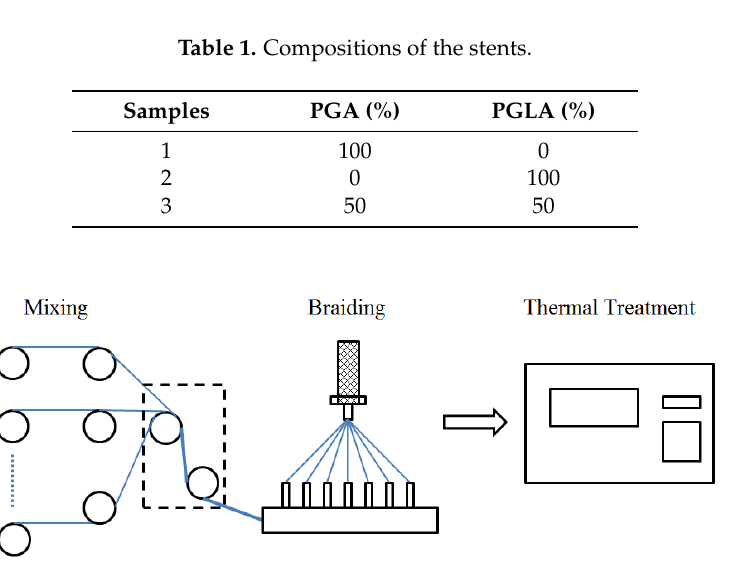
Figure 1. Flow chart for the preparation of the bicomponent ureteral stent.